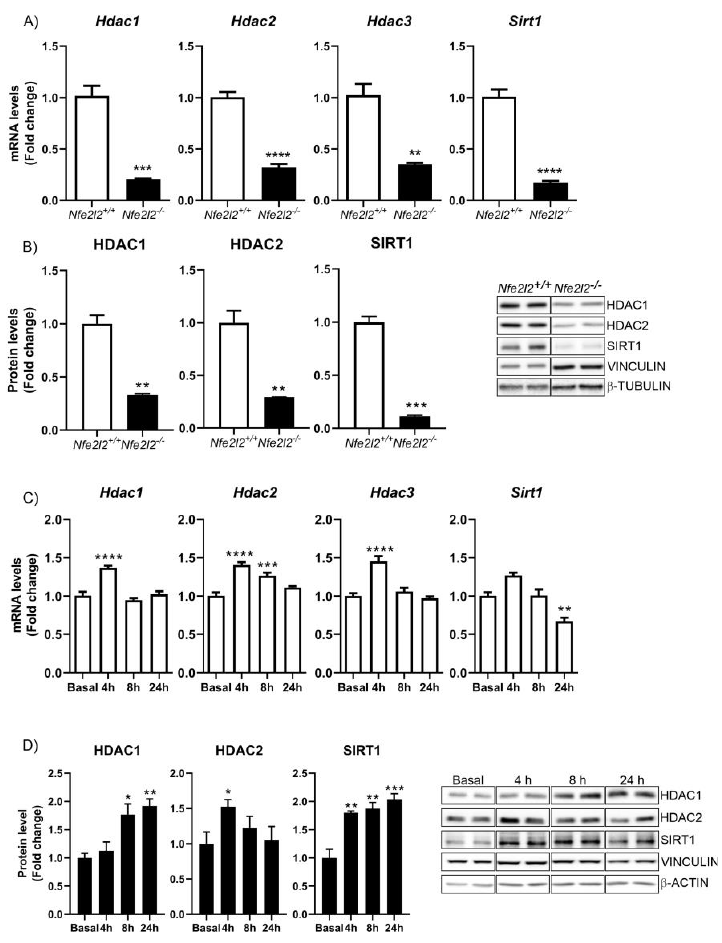
Figure 1. NRF2 promotes the expression of HDCAs. ( A ) qPCR analysis of the levels of Hdac1 , Hdac2 , Hdac3 , and Sirt1 mRNAs in Nfe2l2 +/+ and Nfe2l2 − / − MEFs. n = 34 samples ± SEM. ( B ) The protein levels of HDAC1, HDAC2, HDAC3, and SIRT1 were analyzed via immunoblotting and their respective quantification based on densitometry using the same samples as in ( A ). n = 3–4 samples per experimental group ± SEM. Asterisks denote significant differences ** p < 0.01 and *** p < 0.001, comparing the indicated group with the wild-type mice according to a Student’s t- test. Time-course analysis of treatment of hippocampal HT22 cells with DMF (20 µ M). ( C ) RT-qPCR analysis of the levels of Hdac1 , Hdac2 , Hdac3 , and Sirt1 mRNAs. n = 4 − 5 samples ± SEM. ( D ) The protein levels of HDAC1, HDAC2, HDAC3, and SIRT1 were analyzed via immunoblotting and their respective quantification based on densitometry. n = 3 − 4 samples per experimental group ± SEM. The one-way ANOVA test with a Newman–Keuls posterior test was used to evaluate differences in significance between groups: * p < 0.05, ** p < 0.01, *** p < 0.001 and **** p < 0.0001 compared to basal